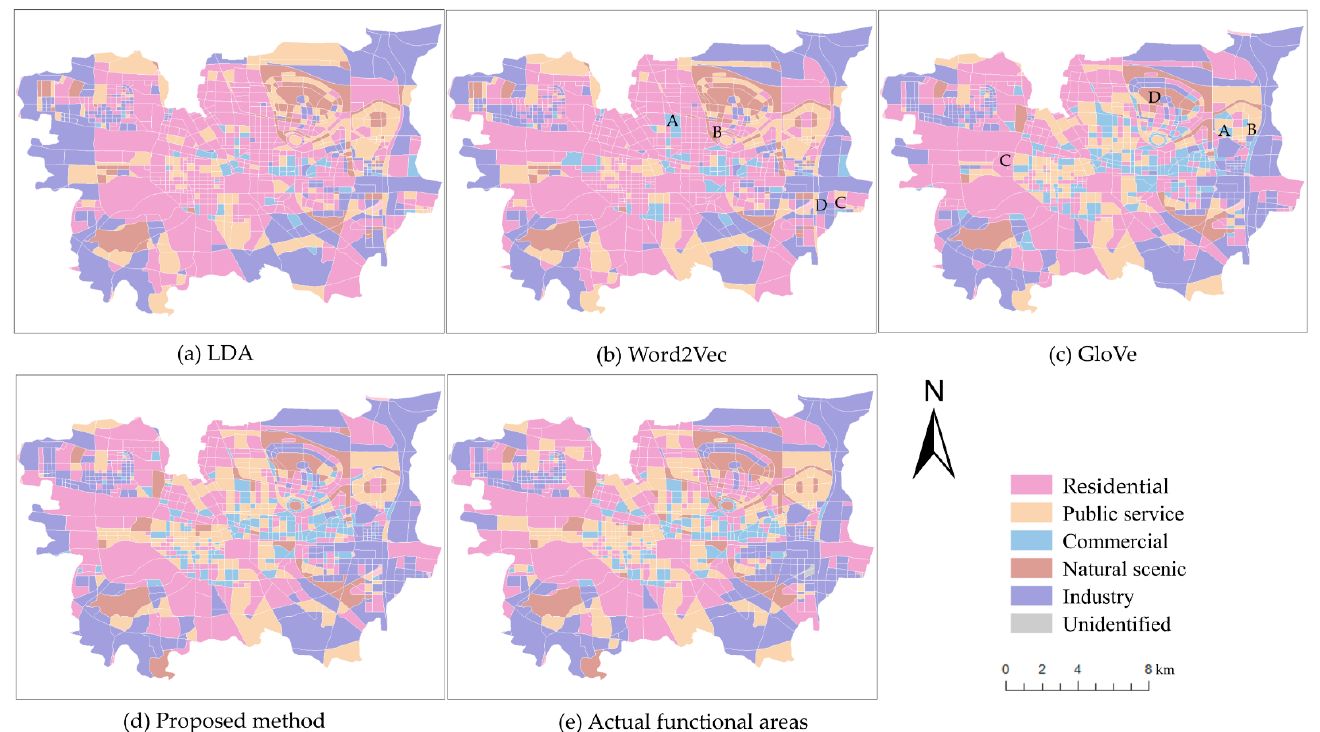
Figure 12. Identification results of different methods. Note: Public Service in the legend is Science, Education and Public Service areas.